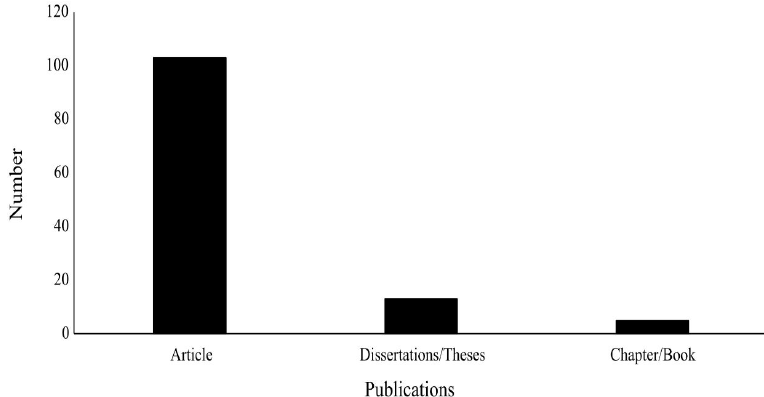
Figure 1. Types of bibliographic production containing morphological descriptions of eggs and/or larvae of freshwater fish in Brazil produced between 1977 and 2018.